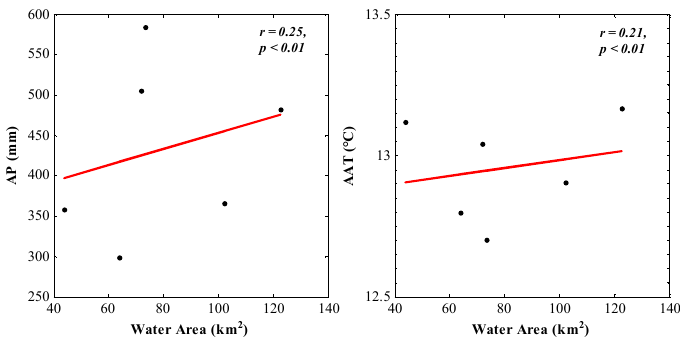
Figure 16. The Pearson correlation coefficient between water area and AAT and AP from 2000–2008.